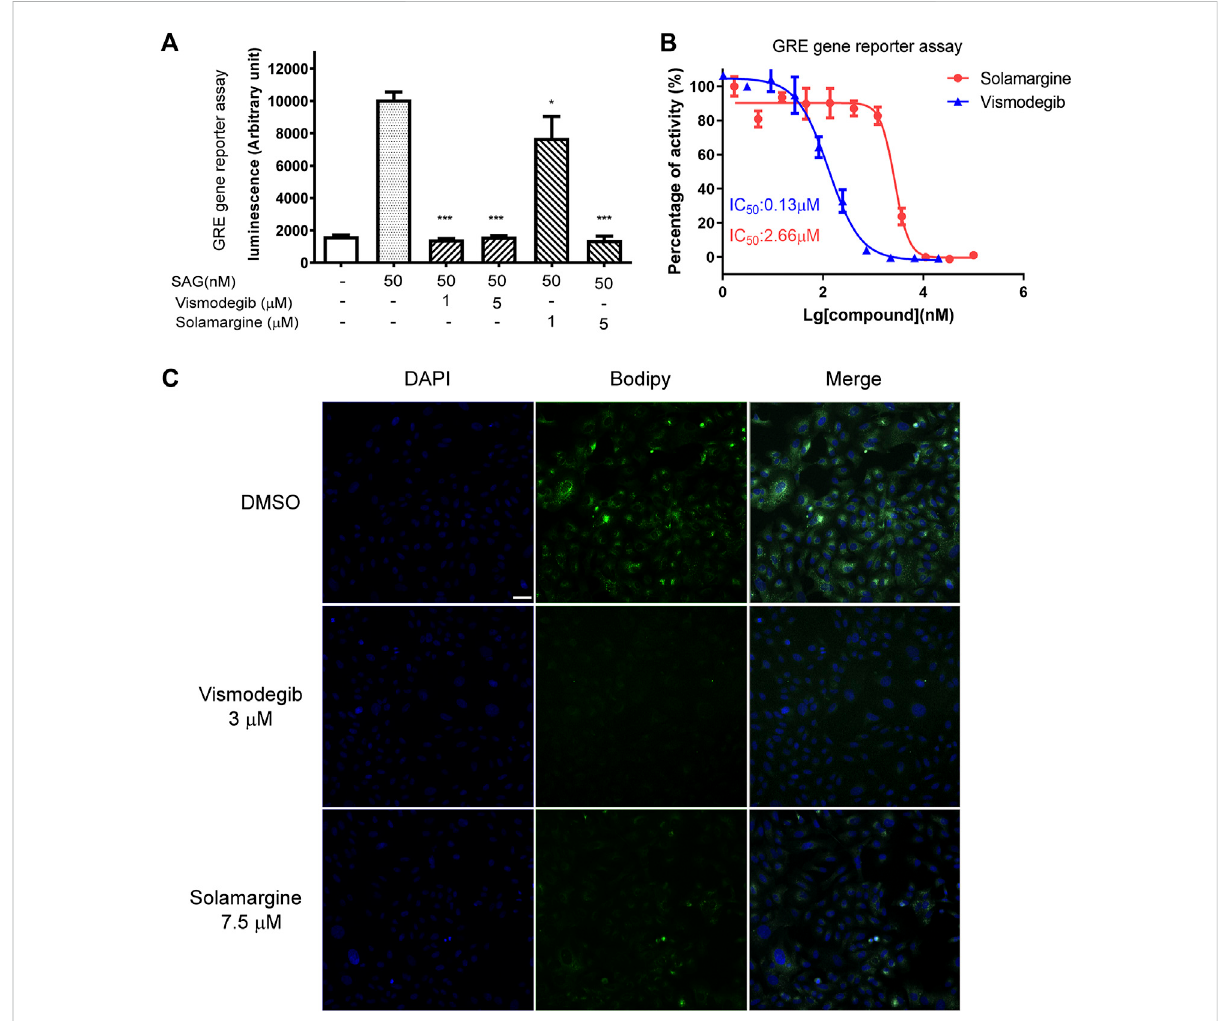
FIGURE 4 Solamargine inhibited the Hedgehog signaling pathway by direct binding to smoothened protein. (A) NIH3T3 cells stably transfected with GRE2-pGL4.26 were plating 15,000 cell/well into 96-well-plates in the assay medium and treated with DMSO (0.1%), vismodegib or Solamargine (1and5 μ M).Gliresponsiveelement(GRE)reportergeneassaywasusedtomeasuretheSHHpathwayactivity.N=3. (B) Thedose-responsecurveof Solamargine and vismodegib in NIH3T3 cells which were stably transfected with GRE2-pGL4.26. (C) 2 × 10 4 U2OS cells were seeded into each well, then fi x the cells DAPI: nuclear staining (the left lane) the next day, or add BODIPY-Cyclopamine (100nM, the middle lane) and Solamargine (7.5 μ M) or vismodegib (3 μ M) co-incubated for 2 h at RT, then measure the fl uorescence signal intensity using a confocal microscope. Scale bar 200 μ m.One-way ANOVA was used for statistical tests.* p <